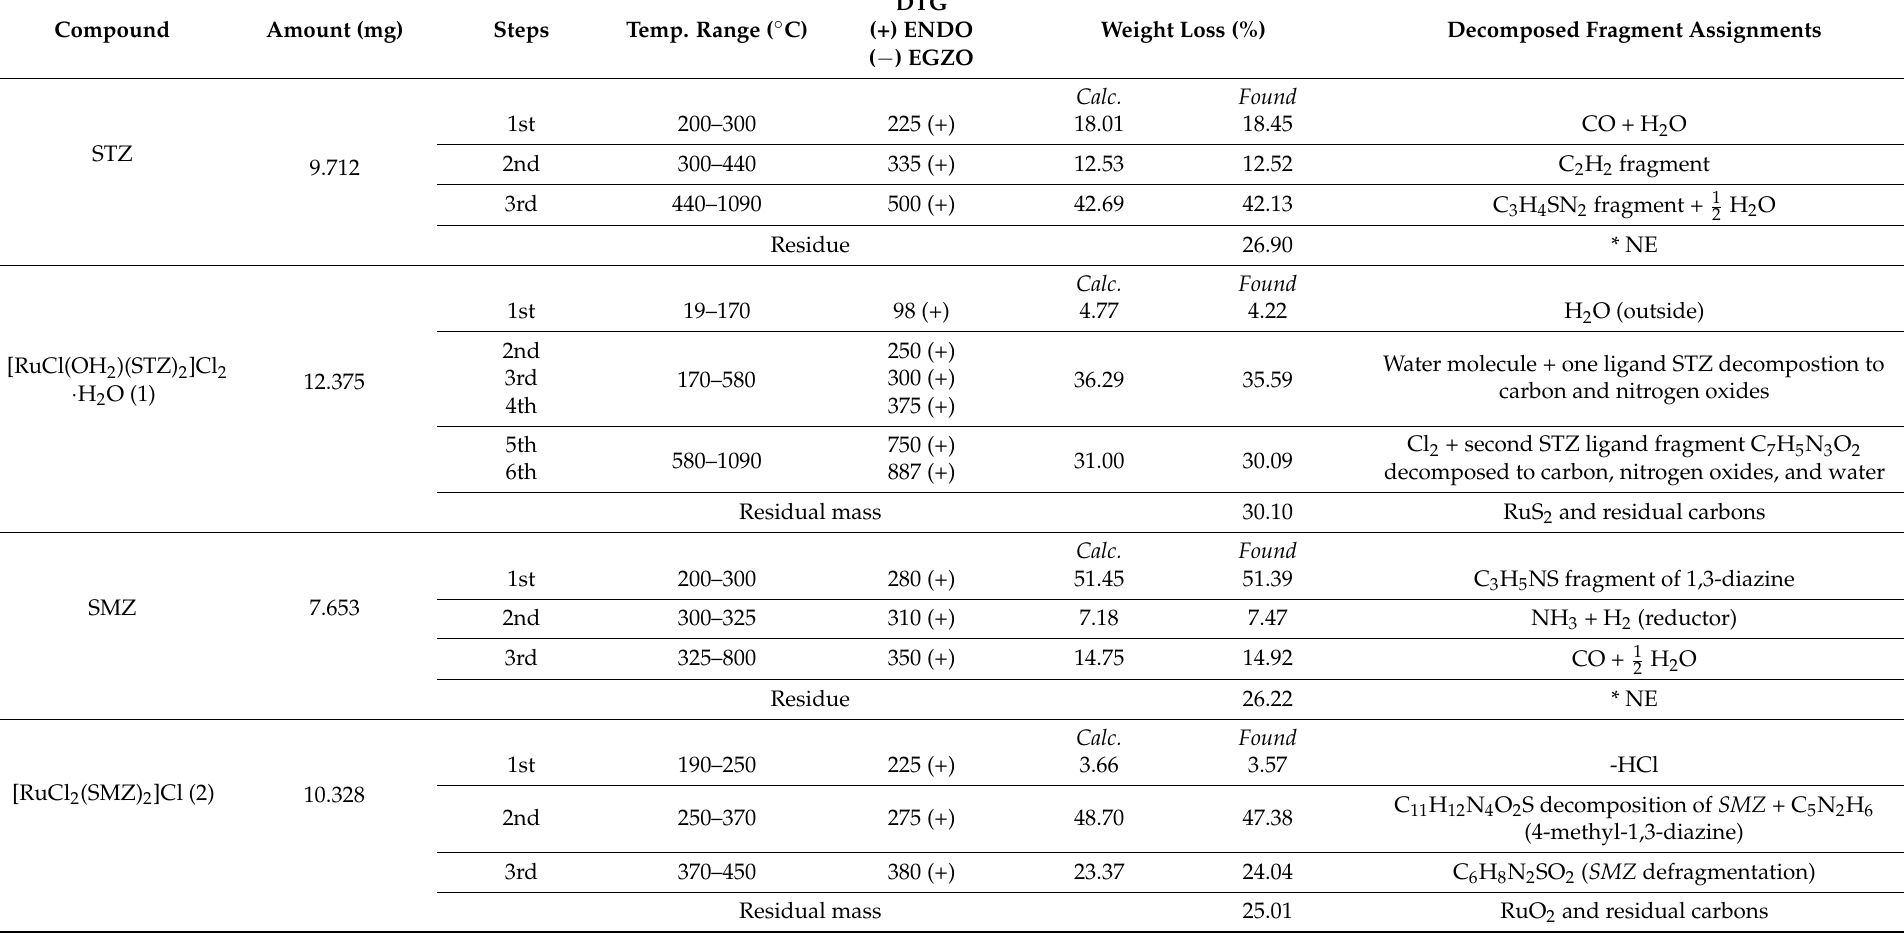
Table 3. The comparative analysis of thermal decomposition data of the sulfa drugs and their Ru(III)